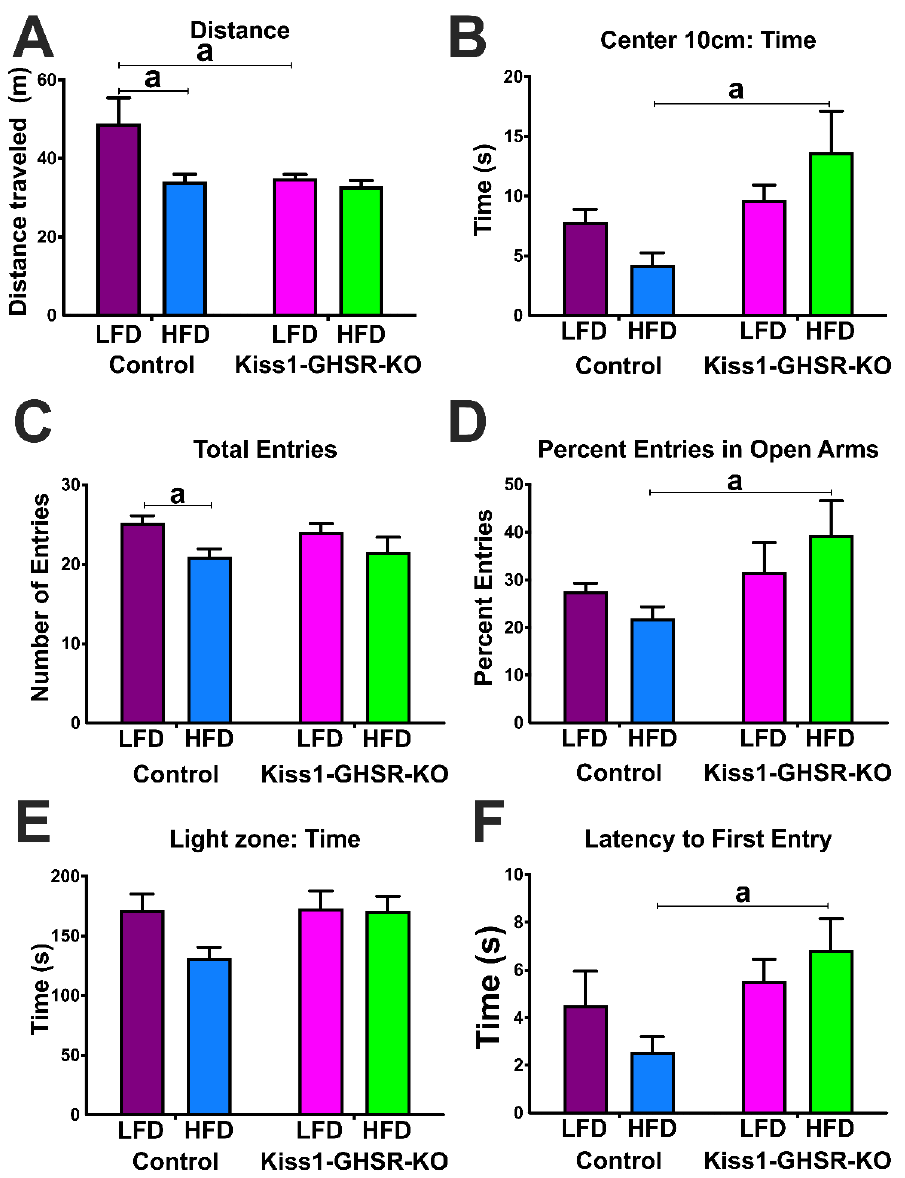
Figure 6. Locomotor and Anxiety-like behaviors in intact control and Kiss1-GHSR KO (KO) female mice fed LFD or HFD for 8 weeks. ( A ) Distance traveled (m) in an Open Field Test (OFT) and ( B ) Time (s) spend in the center zone of OFT. Elevated Plus Maze (EPM) ( C ) Total entries to open arms and ( D ) Percent entries in open arms. Light Dark Box (LDB) ( E ) Time (s) in light zone and ( F ) Latency (s) of first entry to the dark zone (a = p < 0.05). Data are represented as mean ± SEM and n = 8 mice per group. Data were analyzed with two-way ANOVA with post hoc Holm–Sidak’s multiple comparison test. Mice were 20–25 weeks of age during behavior experiments.